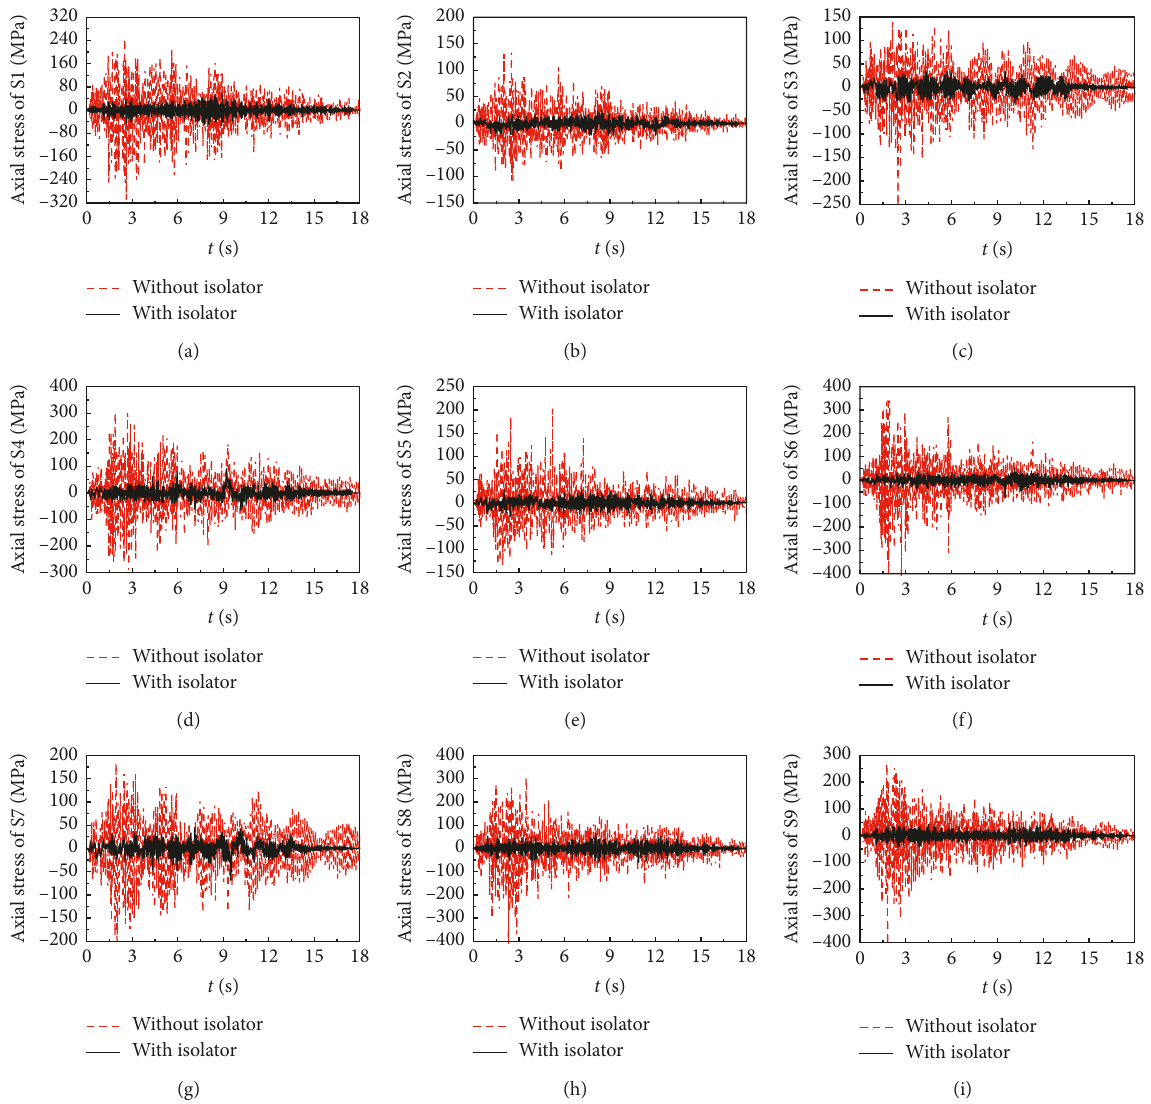
Figure 10: Response of stress time history. (a) Response of stress time history of S1; (b) response of stress time history of S2; (c) response of stress time history of S3; (d) response of stress time history of S4; (e) response of stress time history of S5; (f) response of stress time history of S6; (g) response of stress time history of S7; (h) response of stress time history of S8; (i) response of stress time history of S9.